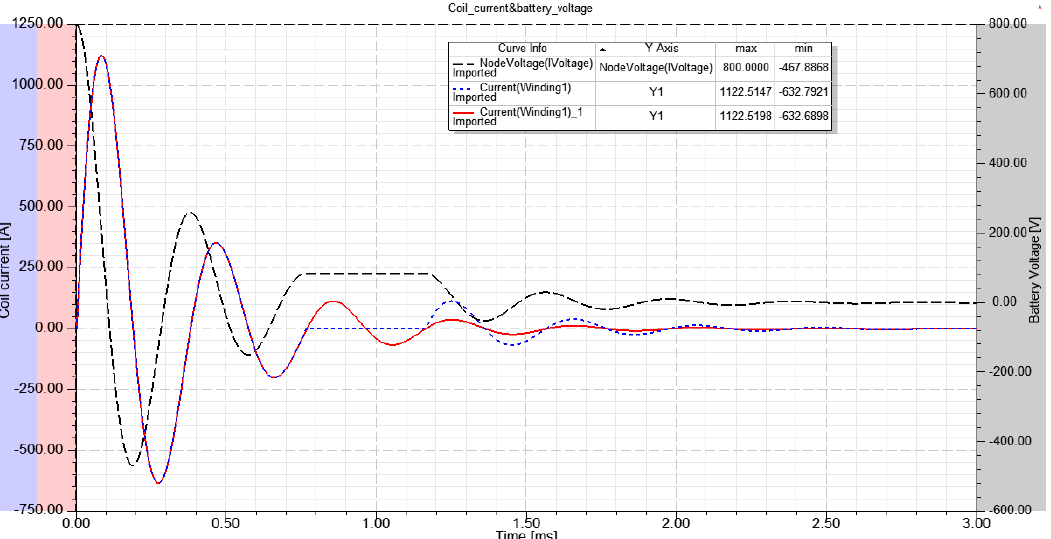
Figure 9. Continuous and discontinuous coil current and battery voltage ( Uc = 800 V), (Case 1 from Table 2). Energies 2018 , 11 , x FOR PEER REVIEW